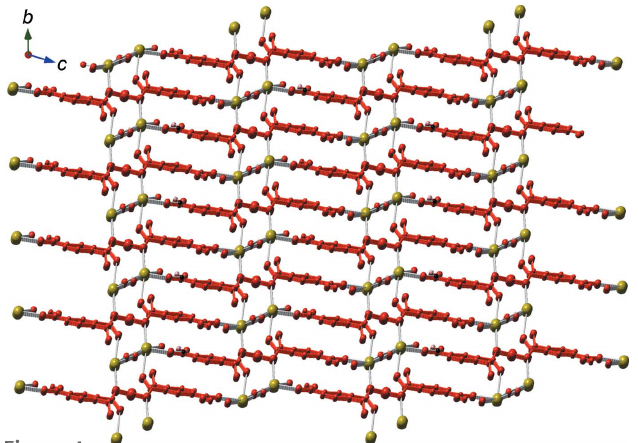
Figure 1 The coordination environments within the title compound, showing the octahedral coordination at the Na I cation and the square-planar coordination at the Cu II cation. Displacement ellipsoids are drawn at the 50% probability level.Symmetry codes are as listed in Table 2.